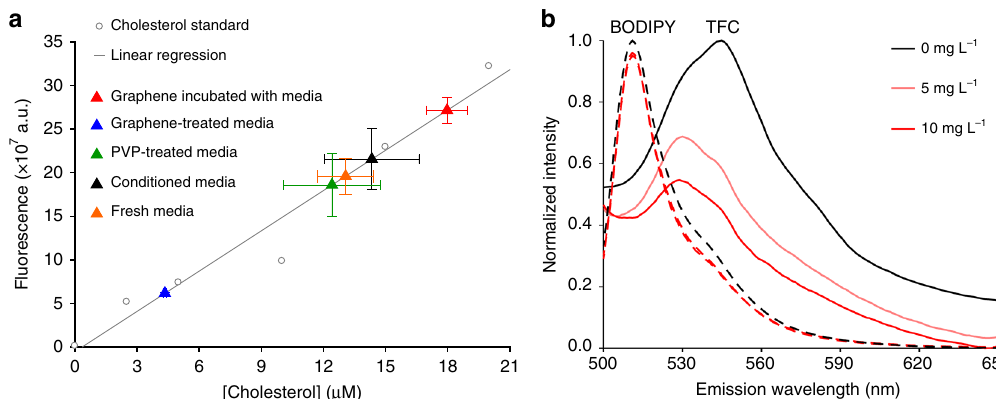
Fig. 1 Graphene interacts with cholesterol. a Cholesterol concentrations (based on the working curve generated from cholesterol standards, gray circles and line) in fresh serum-containing (orange triangle), untreated (black triangle), PVP-treated (green triangle), graphene-treated media (blue triangle), and graphene incubated with media (red triangle). n = 4 samples per batch, N = 4 total batches. Error bars are S.E.M. b Spectro fl uorometer measurements of BODIPY (dashed line) and TFC (solid line) emission after 1-h incubation with graphene (light or dark red), adjusted for the concentration-dependent broadband absorbance of graphene (Supplementary Figure 1) and normalized to the maximum value of 0 mg L -1 graphene and minimum value of 10 mg L -1 graphene at each measured wavelength for